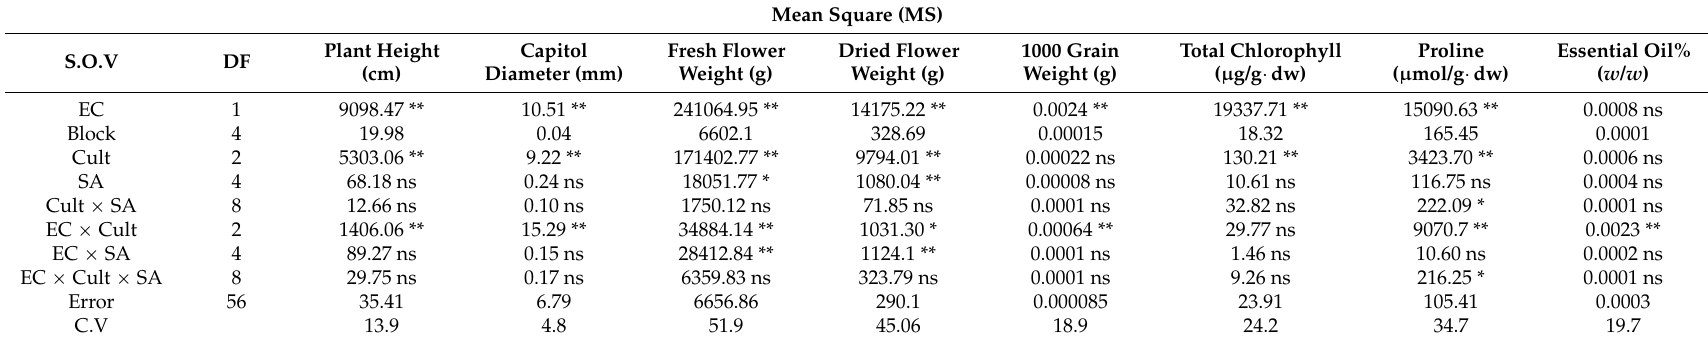
Table 7. Combined analysis of variance for studied traits of German chamomile.